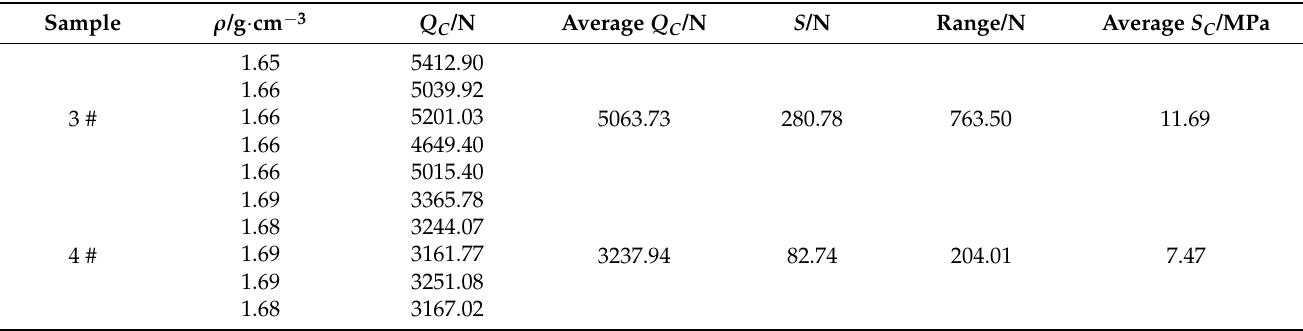
Figure 4. Load–displacement curves of PBX with different RDX. Table 5. Compressive strength of PBX with different